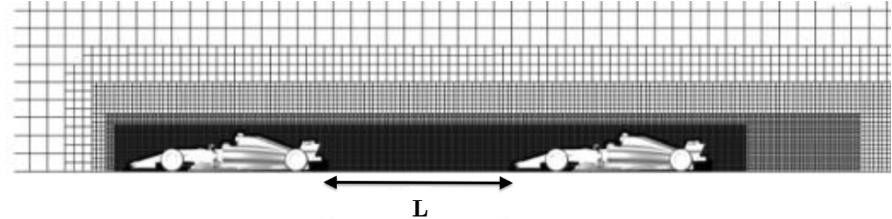
Figure 5. Overall mesh and refinement enclosures under wake effects.